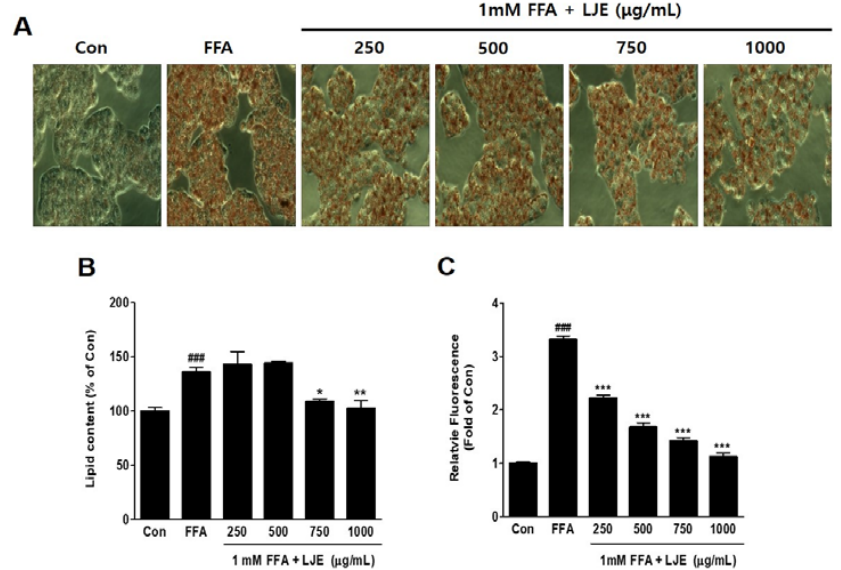
Figure 2. Effect of LJE on intracellular lipid accumulation in HepG2 cells. Control (Con) cells were treated with 1% fat-free bovine serum albumin. ( A ) Oil Red O staining images of HepG2 cells (magnification 200×); ( B ) Quantitative Oil Red O contents at 500 nm; ( C ) Intracellular triglyceride contents were measured by fluorescence intensity. Data represent means ± SEM. ### p < 0.001 vs. Con; * p < 0.05, ** p < 0.01, *** p < 0.001 vs. FFA.